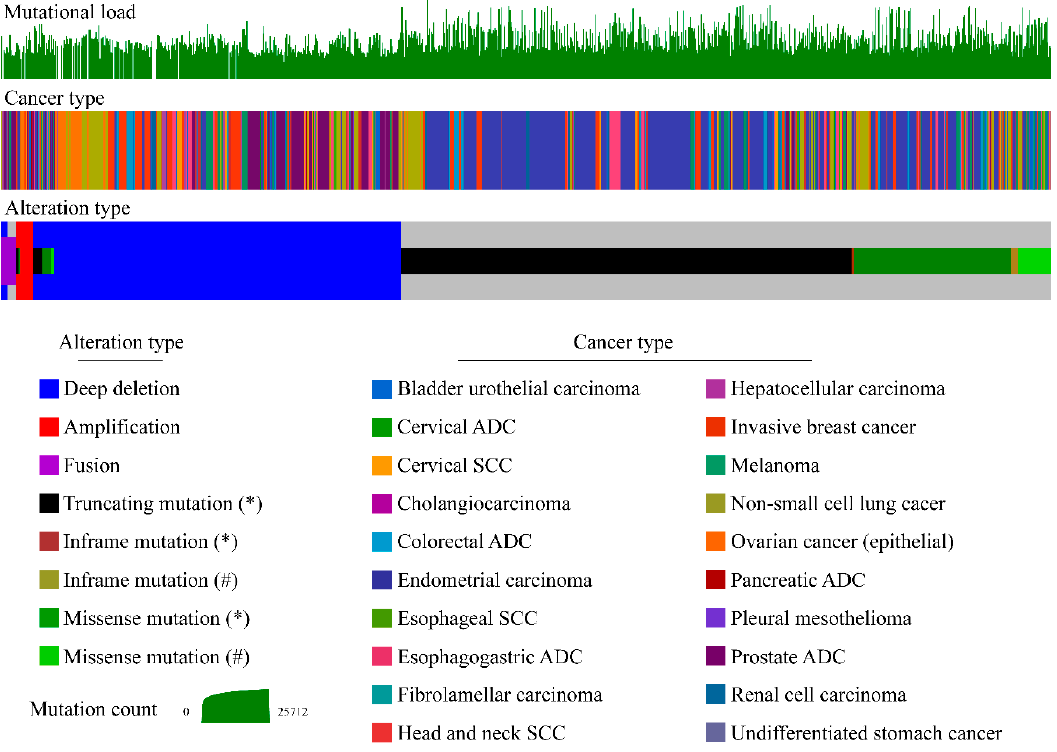
Figure 5. Oncoprint visualization of PTEN somatic molecular alterations overall mutational burden across PTEN-altered solid tumors. Types of alterations and tumors are color-coded on the basis of the legends on the bottom. Each column represents a sample and was sorted to appreciate the magnitude of alteration types. The bar plot on the top represents the mutation count, as reported on the green scale. The 19 main tumor types included in this analysis from cbioportal.org are melanoma, head and neck squamous cell carcinoma, non-small cell lung cancer (i.e., squamous cell and adenocarcinoma), mesothelioma, esophageal cancer, stomach cancer, colorectal cancer, cholangiocarcinoma, pancreatic cancer, liver cancer, renal cell carcinoma, bladder cancer, prostate adenocarcinoma, uterine cancer (i.e., endometrioid, serous, and carcinosarcoma), cervical cancer, ovarian cancer, and invasive breast